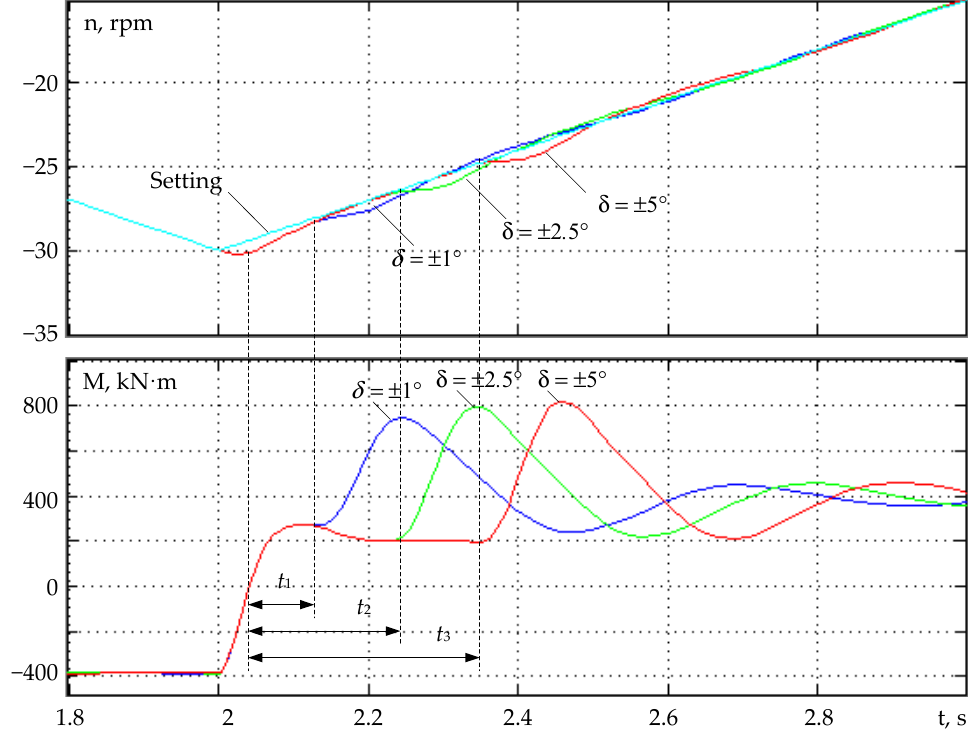
Figure 8. The speed and torque simulation results for different angular gaps. Experimental studies performed on the mill have shown that the angular gaps in the upper and lower roll spindle joints are commonly different. This is mainly caused by different wear of the spindle heads during operation. The difference in gaps is due to different roll loads, operating conditions,